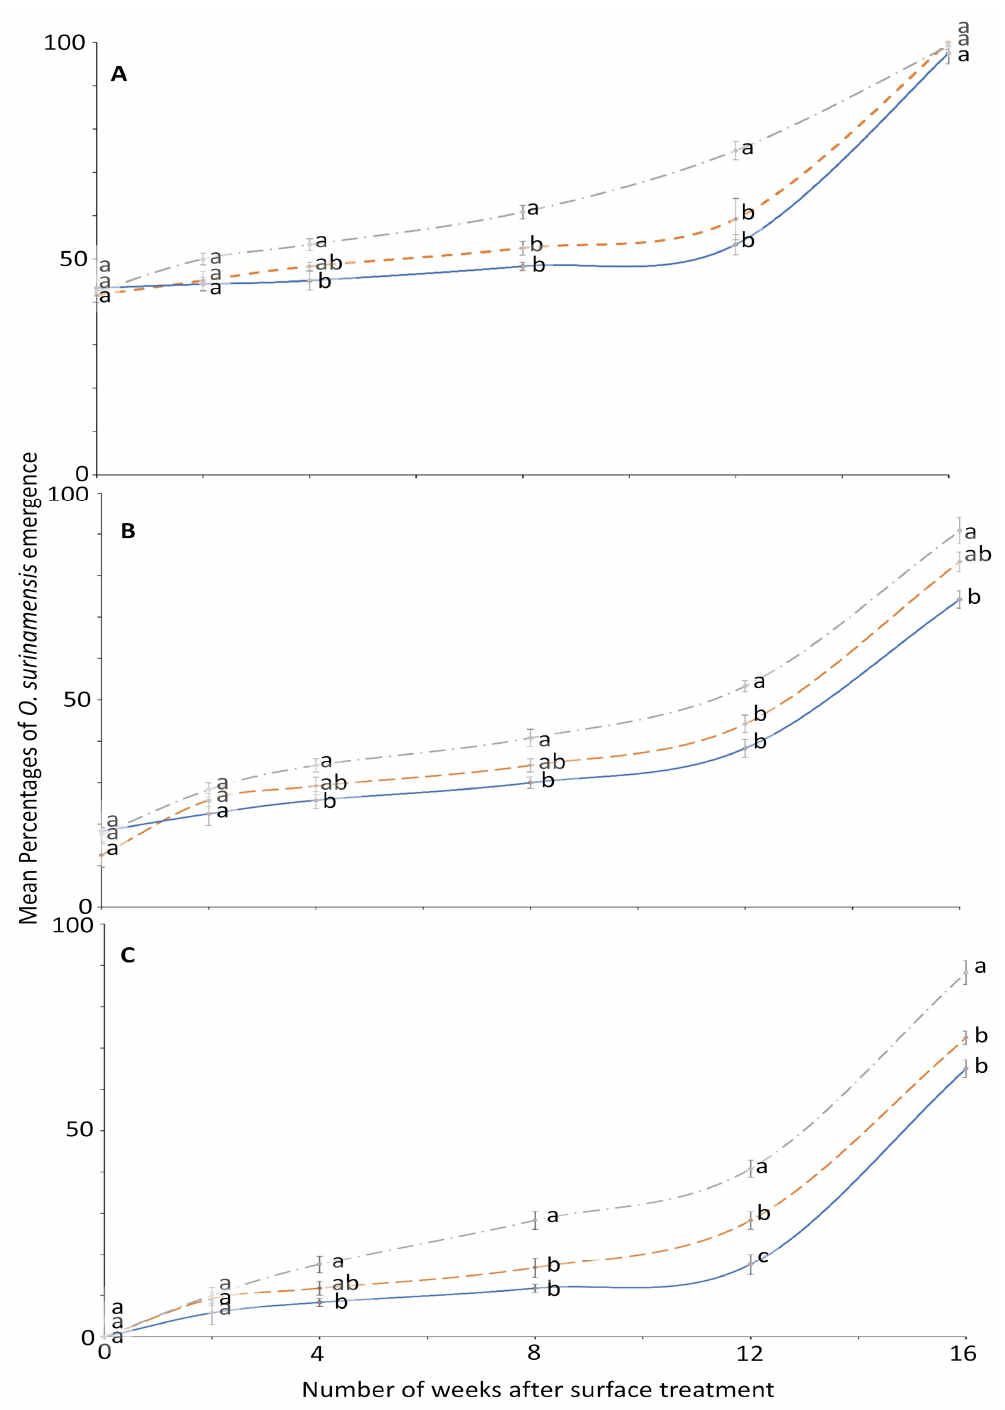
Figure 2. Mean percentages of adults emerging from last-instar O. surinamensis after exposure to novaluron applied 0–16 weeks previously to different surfaces: concrete (dashed line); metal, (solid line); or wood (dashed-dotted line) at concentrations of ( A ) 1-, ( B ) 2-, or ( C ) 4-ppm. In comparisons among mean emergence percentages from different surfaces on a given week after application at a specified concentration, designated a–d above, percentages with the same letter are not significantly different.